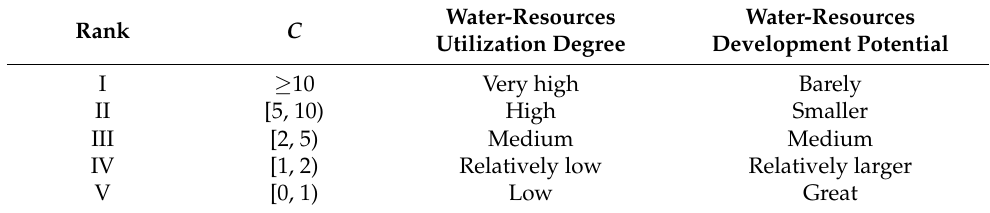
Table 1. Water-resources load index level division